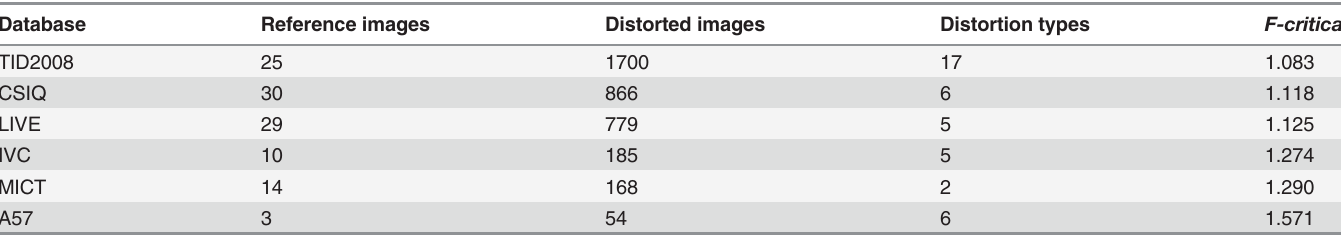
Table 1. Some information about databases.